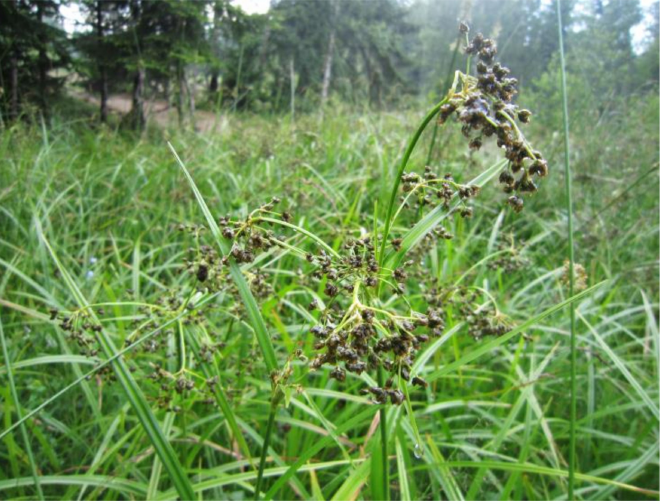
Figure 10. The association Scirpetum sylvatici Ralski 1931 (Serbia, photo V. Djordjevi´c).